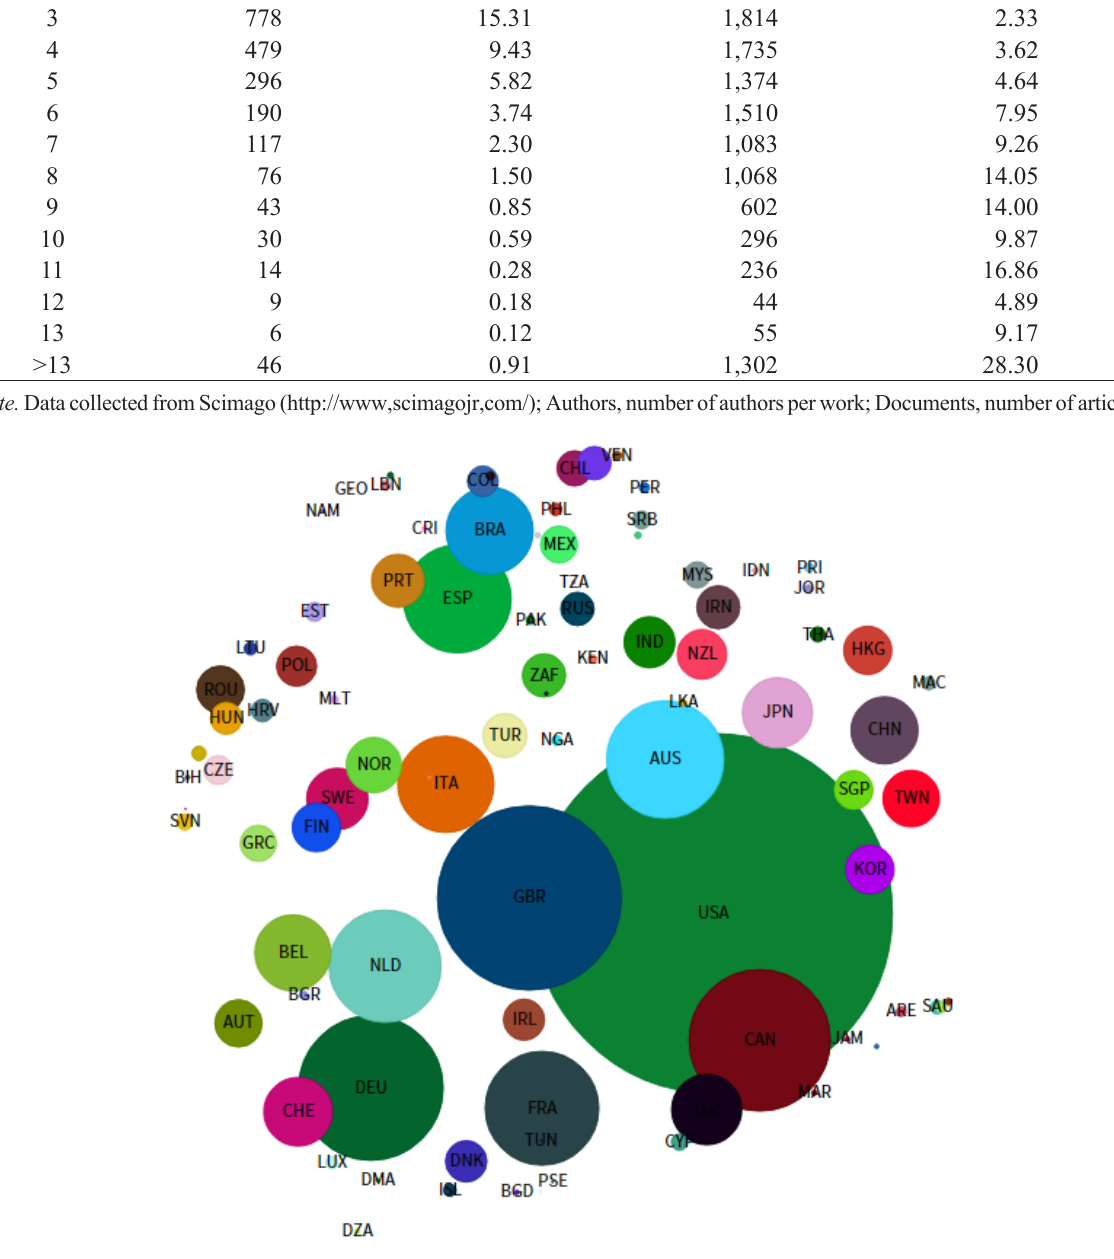
Figure 1. Collaboration network in psychology represented by countries in